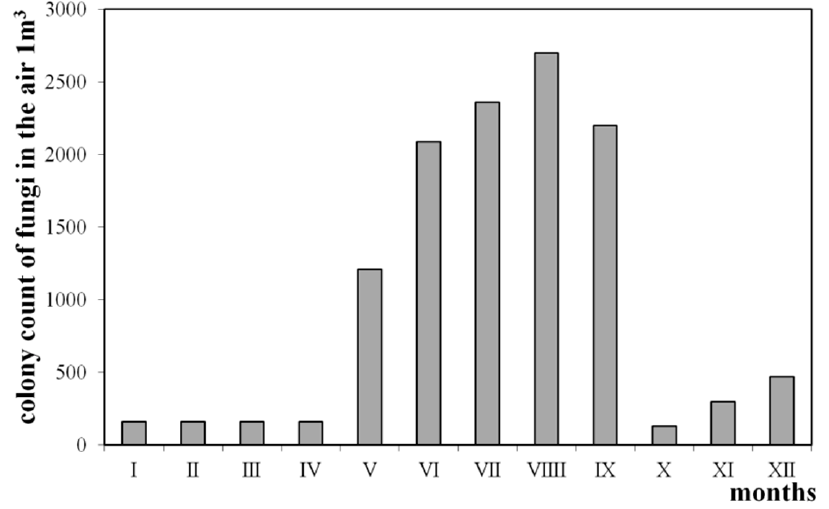
Figure 3. The concentration of mold spores in the room air in the annual cycle [25].